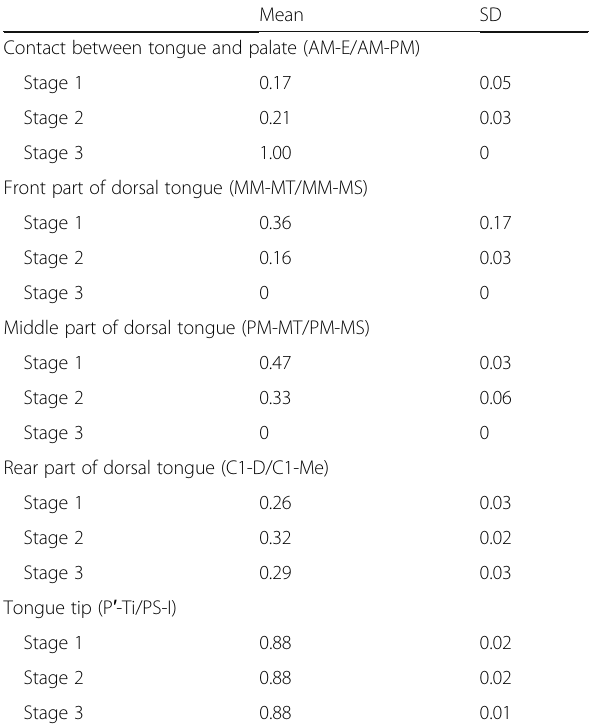
Table 2 Measurements (ratio) for each stage of